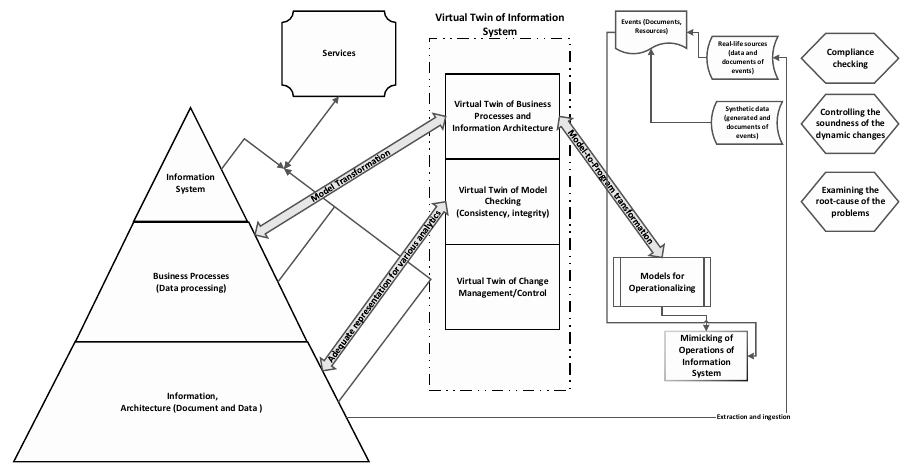
Figure 17. The Virtual Twin Framework for Mimicking the Behavior of Information